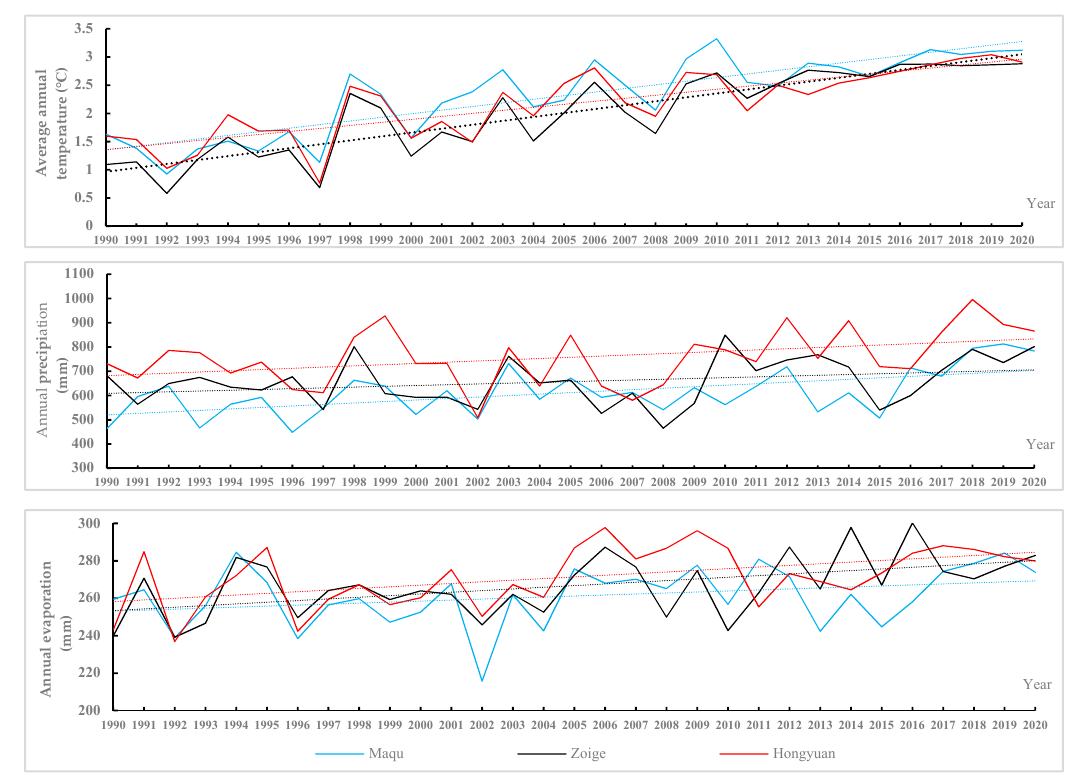
Figure 2. Annual temperature, precipitation, and evaporation at 3 stations, ZP, from 1990 to 2020.